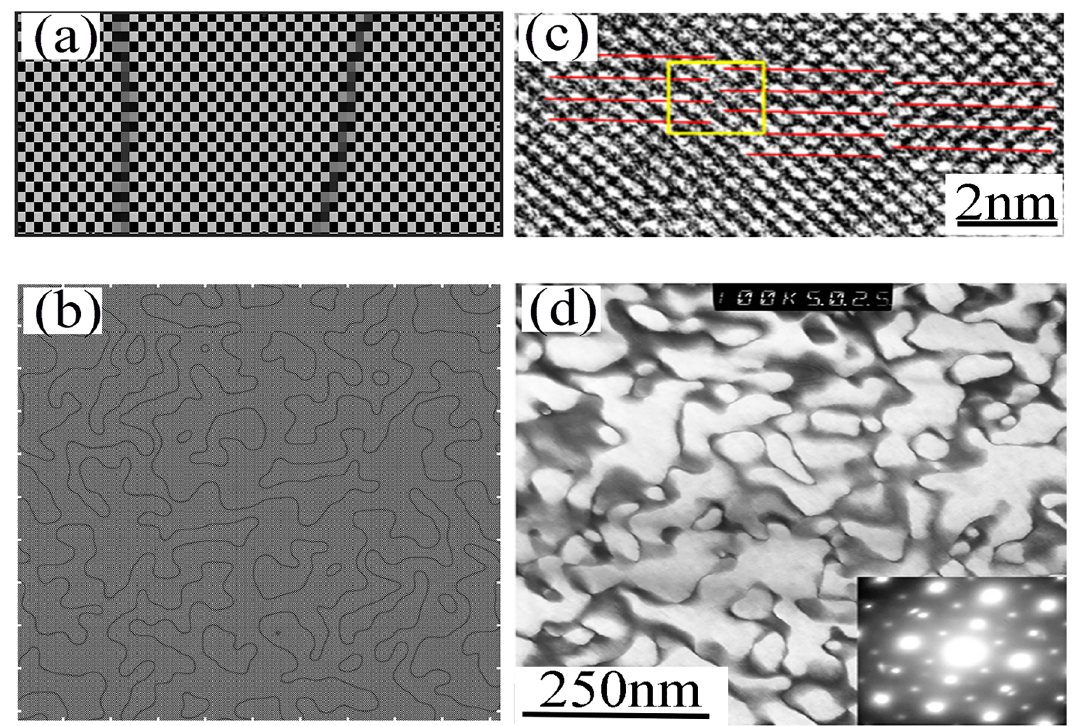
Figure 6. (a) The exhibition of B2-FeAl APD(B) of nano-scaled size in MPF simulation. (b) The map of APDBs morphology obtained through MPF simulation. (c) The observation on B2-FeAl APDs under high-resolution transmission electron microscopy (HTEM) in experiment 33 . (d) The observation of APDBs morphology in experiment 18